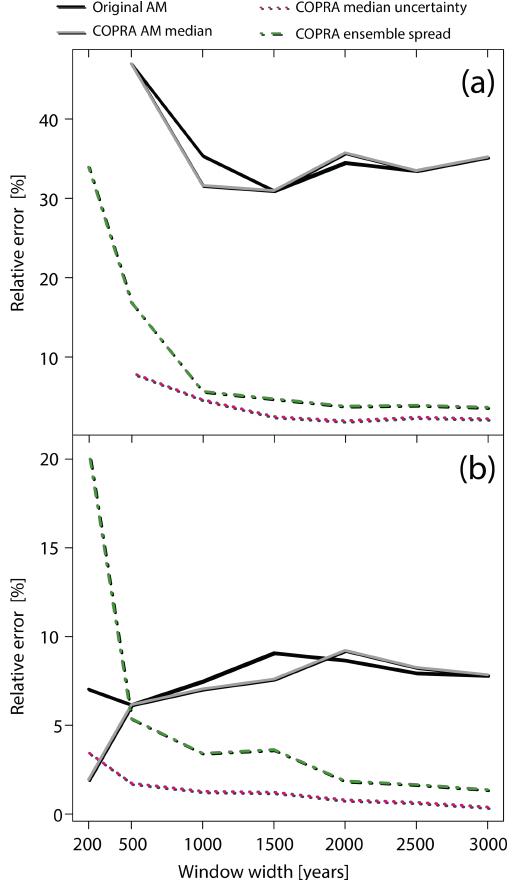
Figure 6. LGM period definitions and their impact on SISAL δ 18 O mean estimate uncertainty. The impact of the window definition and age uncertainty is explored for two entities: (a) entity BT-2 from Bo- tuverá cave (Cruz et al., 2005) and (b) entity SSC01 from Gunung- buda cave (Partin et al., 2007). The relative error is defined as 2 stan- dard deviation for the original age model and the COPRA median; and the upper minus lower 95% quantiles for the COPRA median uncertainty as well as the COPRA ensemble spread of standard de- viations. Black solid lines give the relative error of the mean isotope estimate for the LGM for the original age model and grey solid lines give the estimate based on the COPRA median age model. The pink dotted line shows the uncertainty of the COPRA median estimate, and the green dashed line the average relative error estimate across the 1000-member COPRA ensemble. For both speleothems, rela- tively stable error estimates are found for window sizes larger than ± 750 years, whereas the relative error increases towards smaller window